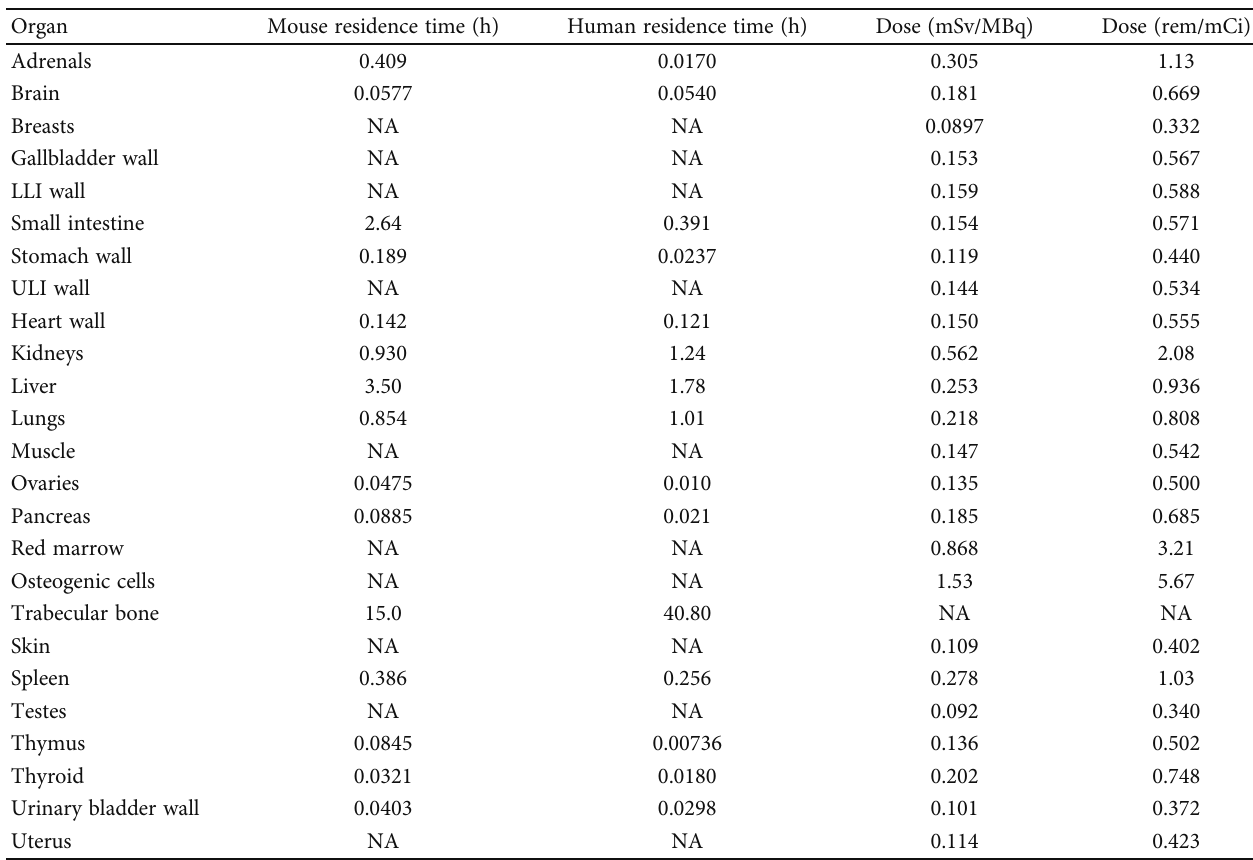
Table 1: [ 89 Zr]Zr-DFO-NC318 human dosimetry extrapolated from Balb/c mouse biodistributions (includes the organs used in the kinetics input form of OLINDA, the mouse residence times, the extrapolated human residence times, and the dose the tissue received per unit injected